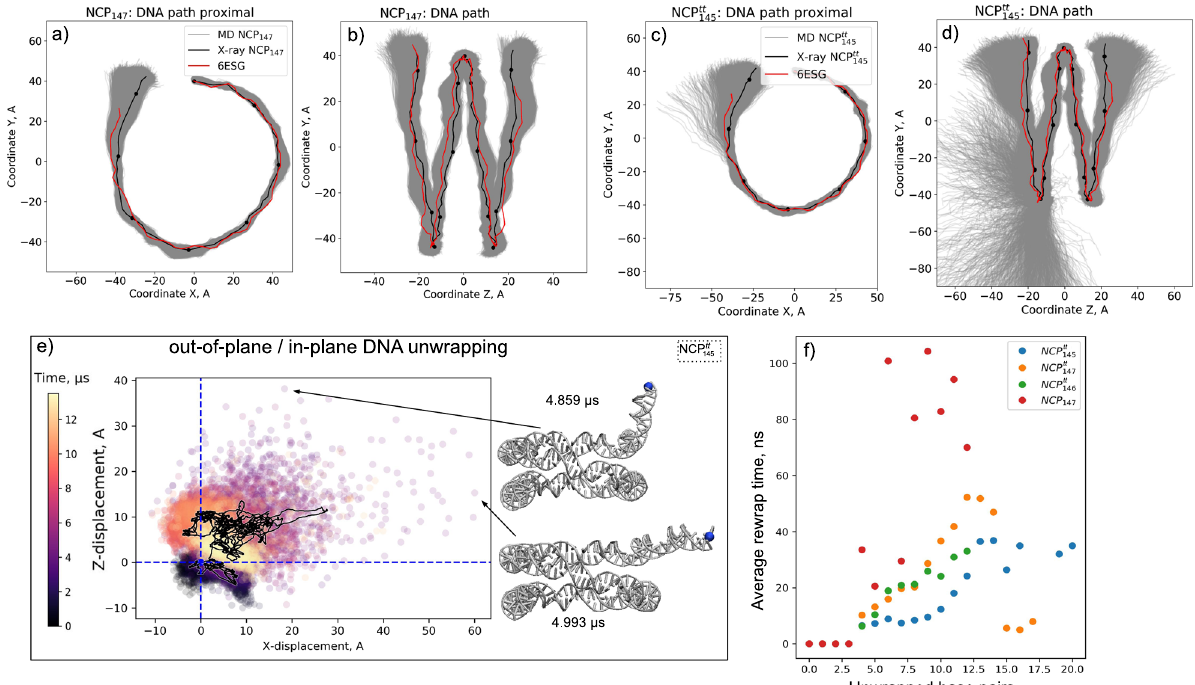
Fig. 5 Characteristics of DNA unwrapping in nucleosomes. a – d 2D projections of DNA paths in nucleosome reference frame for NCP 147 and NCP tt 145 systems; e Scatter plot of DNA end fl uctuations along the Z and X -axis of the nucleosomal reference frame relative to its initial position in NCP tt 145 simulation; f Average DNA rewrapping times as a function of DNA unwrapping extent estimated from MD trajectories. States with up to three unwrapped base pairs are considered as a wrapped state for this analysis.